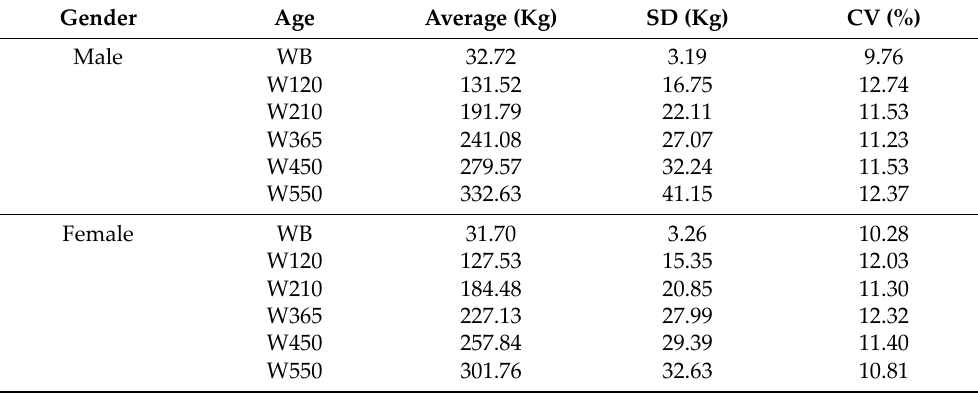
Table 2. Estimates of means, standard deviations (SD), and coefficients of variation (CV) of body weight at birth (WB), 120 (W120), 210 (W210), 365 (W365), 450 (W450), and 550 (W550) days of age, in kg, by gender (2088 males and 3348 females).